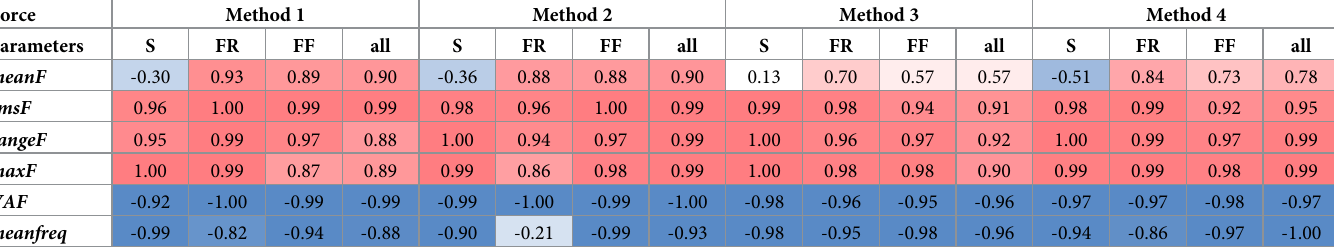
Table 4. Correlation coefficients between CISI and the six force parameters meanF , rmsF , rangeF , maxF , VAF and meanfreq . The strength of the correlation is coded with a color gradient, highlighting the strong positive ( > 0.8) (dense red) and strong negative ( < − 0.8) (dense blue) correlations.